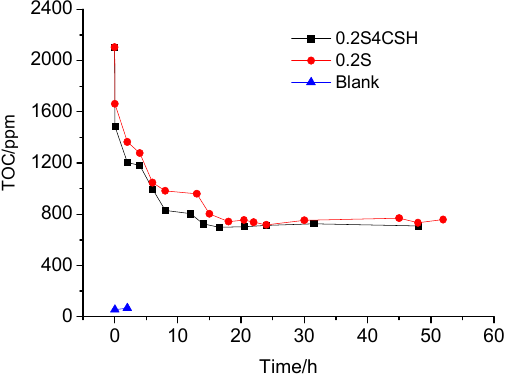
Figure 10. TOC content in pore solutions of the fresh cement pastes with a water cement ratio of 0.40 and with 0.2 wt.% sucrose and 4.0 wt.% nano-C-S-H gel addition.